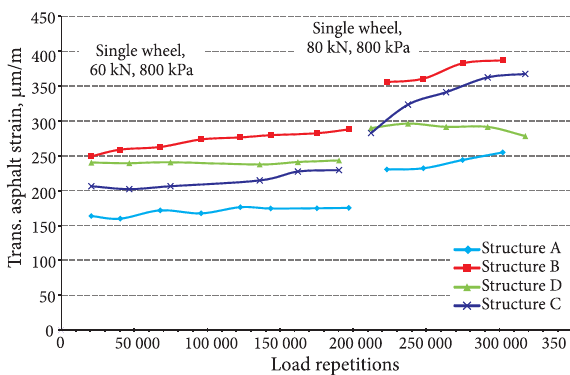
Fig. 6. Development of transverse horizontal strain in the bottom of asphalt layers (ε ye )